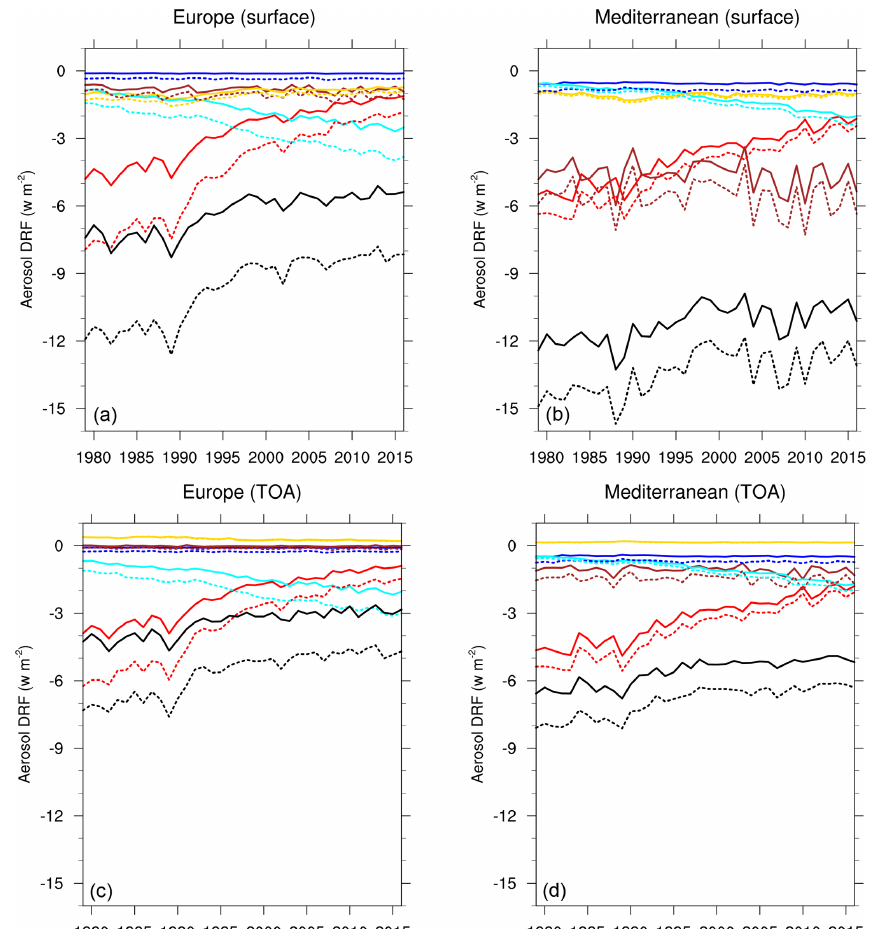
Figure 14. Yearly means of aerosol DRF over Europe (a, c) and the Mediterranean Sea (b, d) for nitrate and ammonium (cyan), sulfate and organics (red), black carbon (yellow), dust (brown), sea salt (blue), and total (black) in all sky (solid lines) and clear-sky (dotted lines) conditions over the period